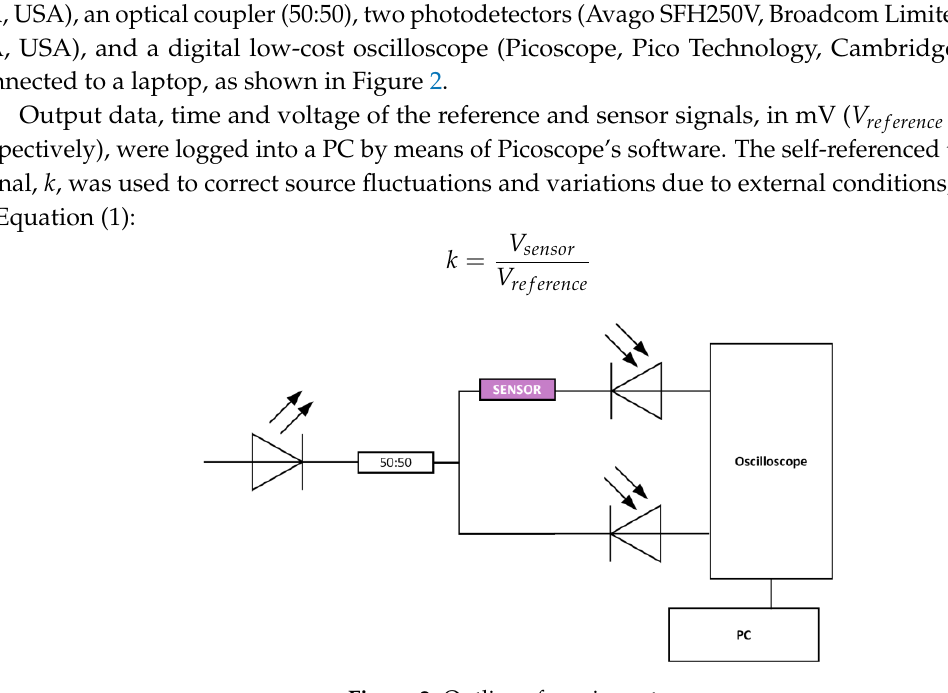
Figure 2. Outline of sensing setup.